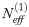
EWS for γ = 5.An increase in standard deviation as well as autocorrelation can be observed prior to the critical transition, both for the natural state N(1) (blue) and the effective state Neff(1) (green) in networks with γ = 5.